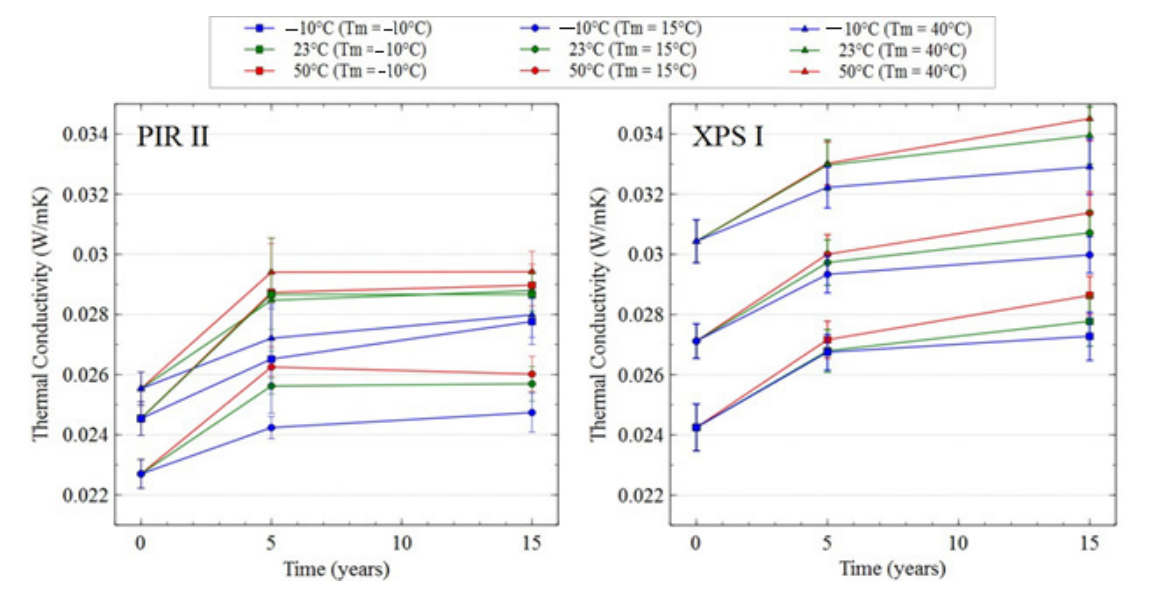
Figure 7. Change in thermal conductivity measured at mean temperatures of − 10, 15 and 40 ◦ C on specimens conditioned at − 10, 23 and 50 ◦